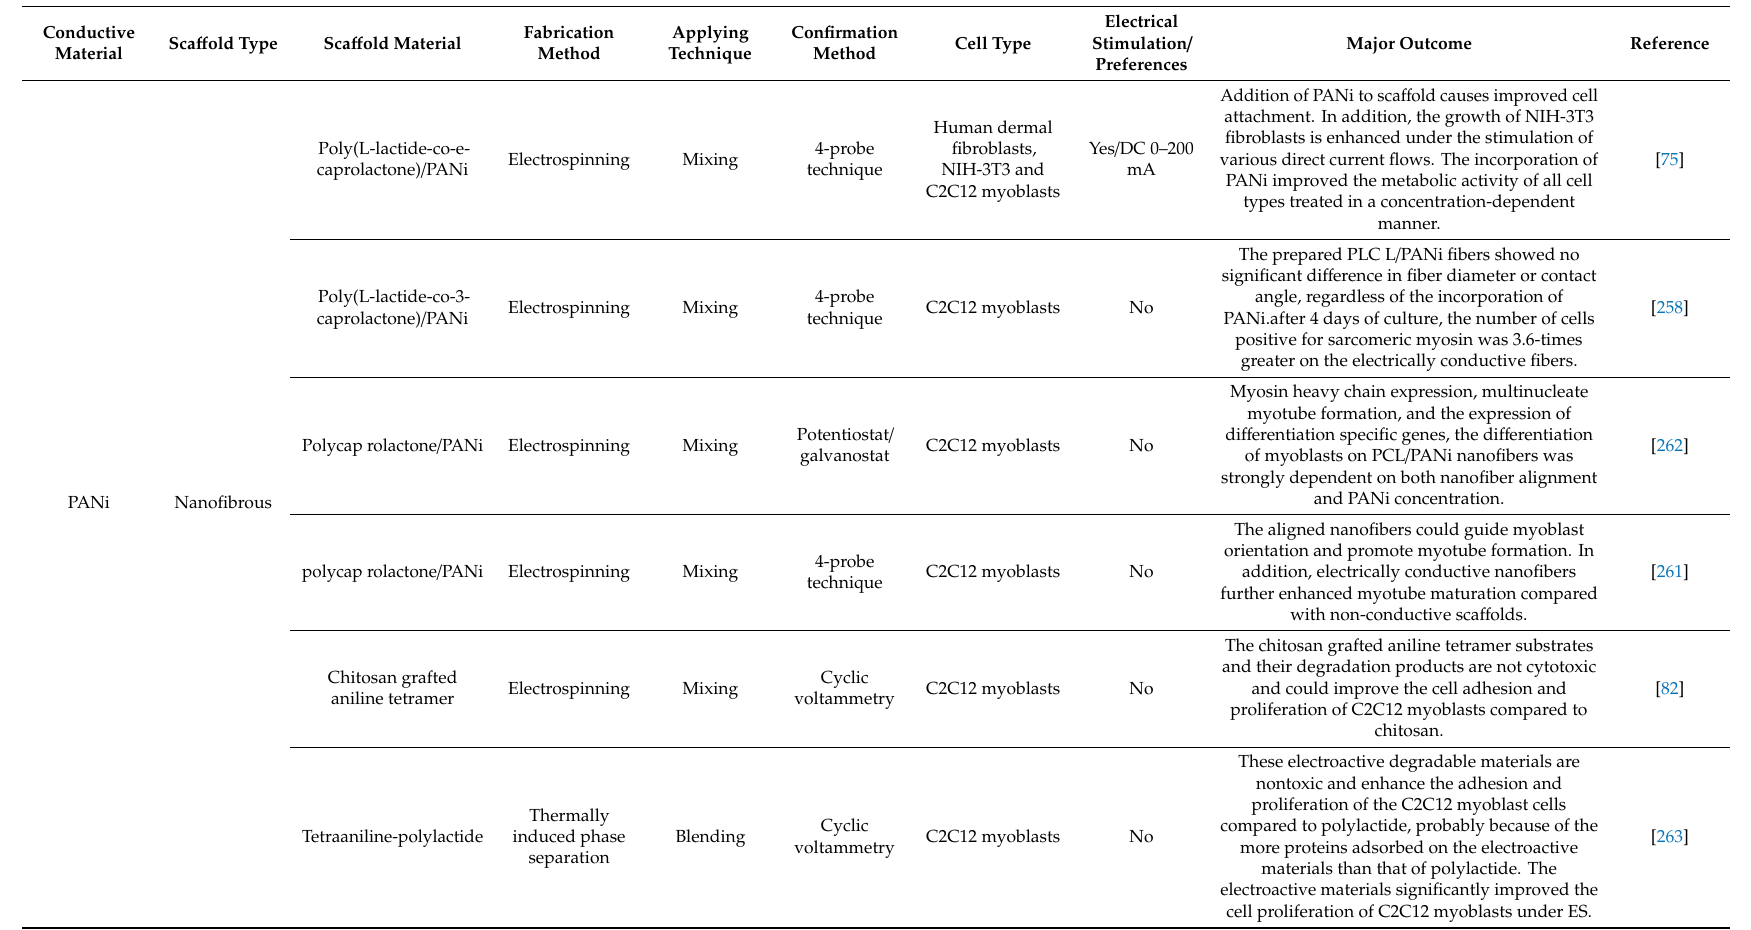
Table 5. Conductive sca ff olds used in muscular tissue